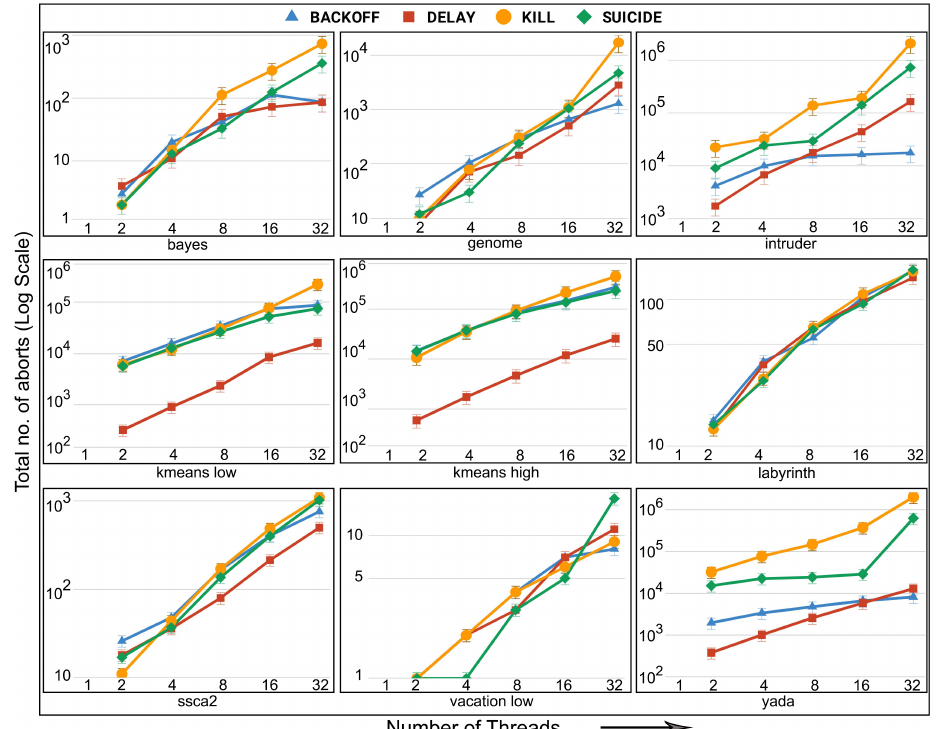
Figure 29. Aborts in STAMP benchmarks for Adaptive _ ETL for four different contention manage- ment techniques in non-persistent